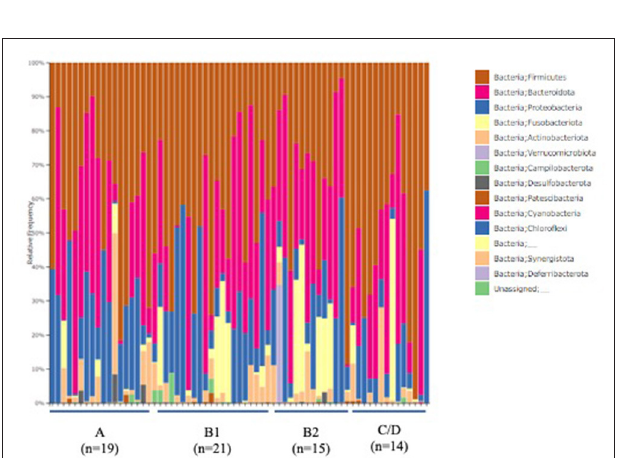
FIGURE 1 | α -diversity: Shannon index based on operational taxonomic unit abundance of healthy Chihuahuas (H) and Chihuahuas with myxomatous mitral valve disease divided into three groups (B1, B2, and C/D).